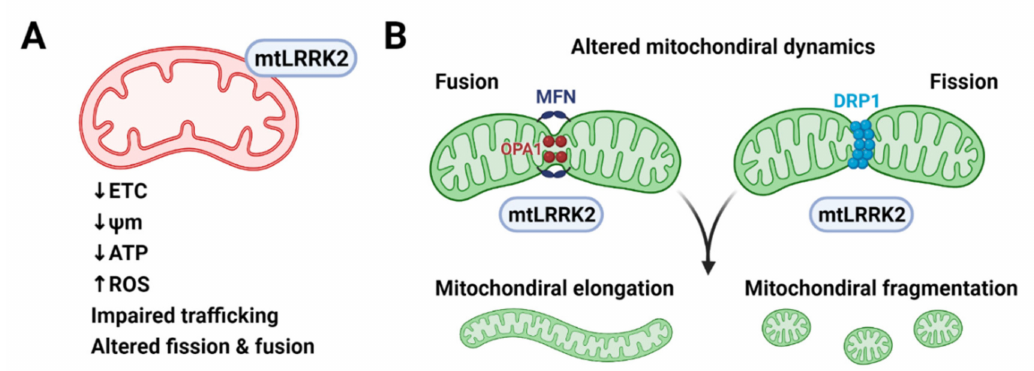
Figure 3. Mitochondrial dysfunction caused by pathogenic LRRK2 mutants. ( A ) Pathogenic LRRK2 mutants (mtLRRK2) reduce the activity of electron transfer chain (ETC) reaction and mitochondria membrane potential ( ψ m), resulting in inefficient ATP production and increased reactive oxygen species (ROS) production. ( B ) Pathogenic LRRK2 mutants interact with mitochondria fusion proteins, such as mitofusin (MFN) and optic atrophy protein 1 (OPA1) and mitochondria fission proteins, such as dynamin-related protein 1 (DRP1). Pathogenic LRRK2 mutants alter mitochondrial morphology and dynamics presumably by interacting with the fusion and fission machinery but the exact molecular mechanism awaits to be elucidated. Created with BioRender.com (accessed on 13 February